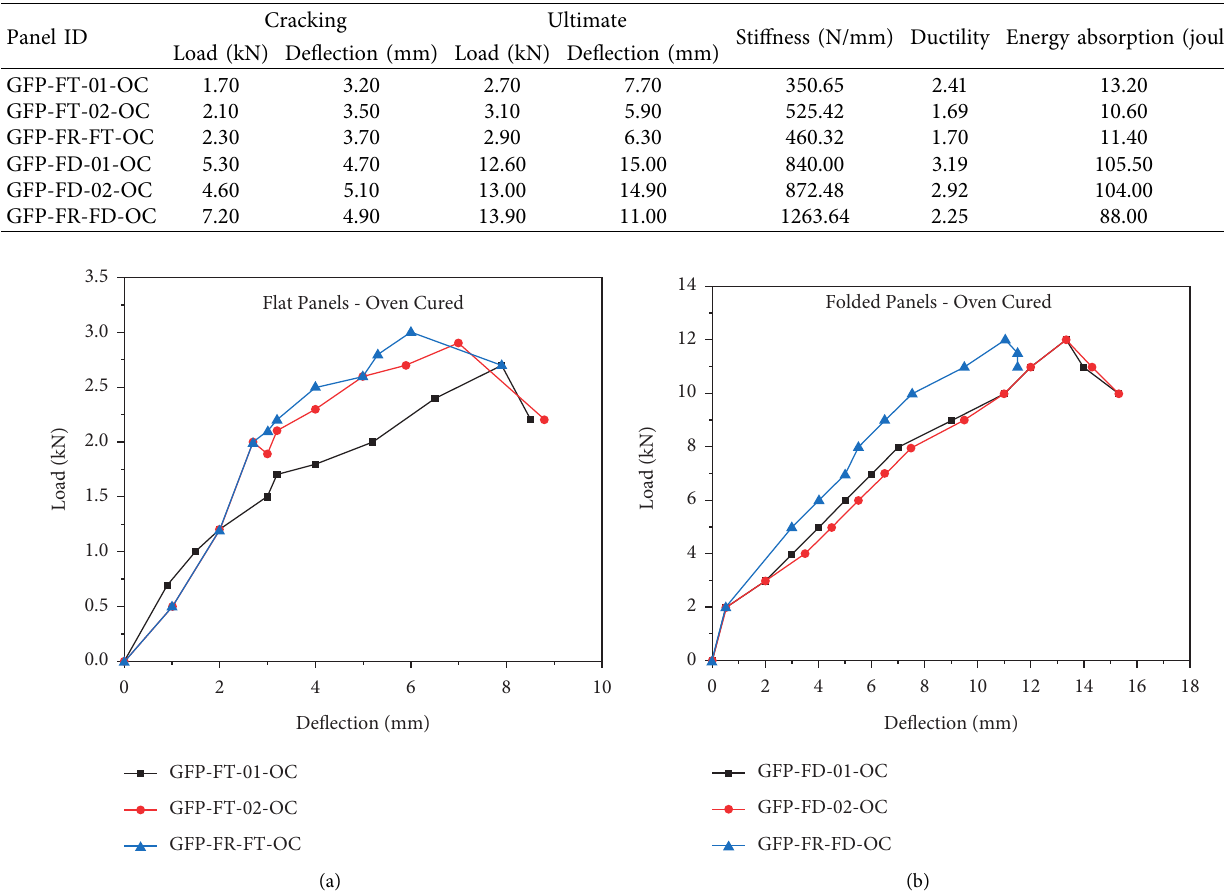
Table 4: Load, deflection, and flexural strength of GF panels.